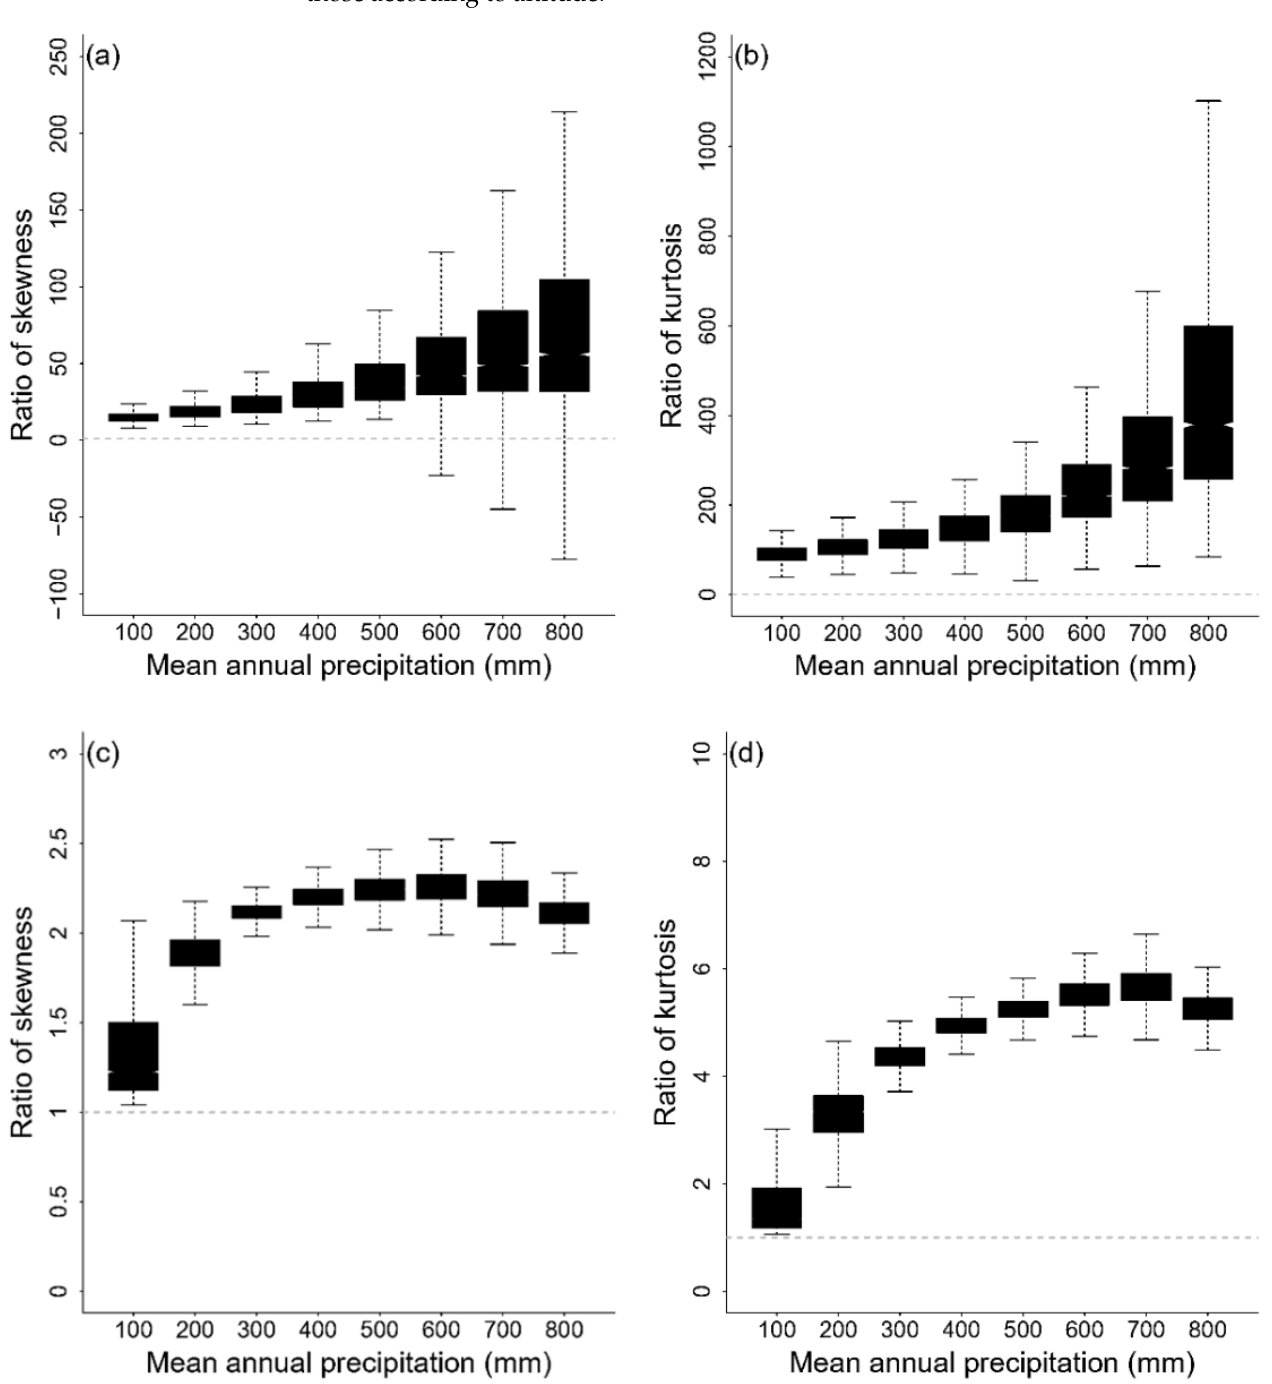
Figure 4. The ratio of high-order statistical parameters of annual precipitation distribution before and after daily precipitation manipulation along the gradient of mean annual precipitation. Normal distribution: skewness ( a ) and kurtosis ( b ); probability-based distribution: skewness ( c ) and kurtosis ( d ). The grey dashed line denotes a value of 1 for the vertical axis.